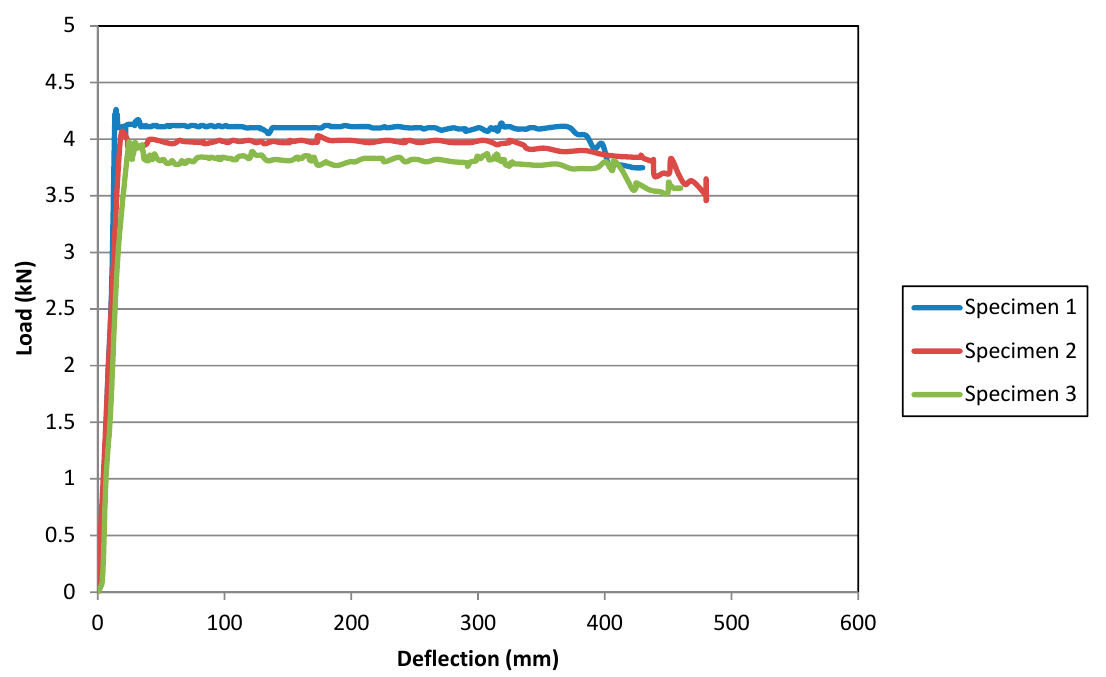
Figure 23. Load versus vertical deformation for the test specimens. The relation between the vertical deflection and the horizontal displacement at the top and bottom LVDTs for the three specimens are illustrated in Figures 24 and 25, respectively.